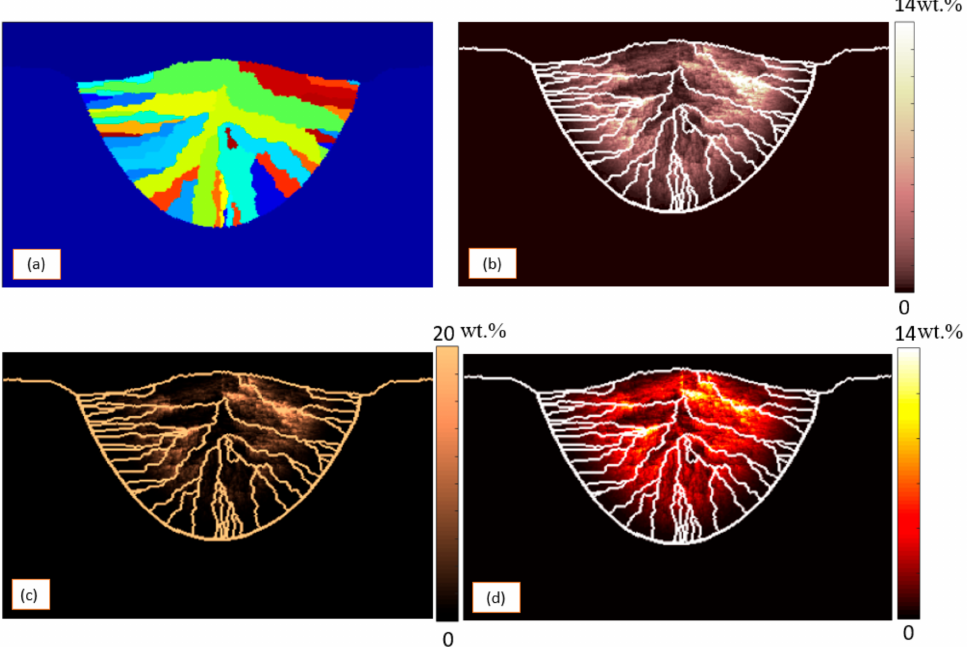
Figure 3. Simulation results for solidification behavior at 280 J/m. ( a ) Grain structure inside the track, ( b ) Nb concentration after laser melting; ( c ) Ti concentration after laser melting; ( d ) C concentration after laser